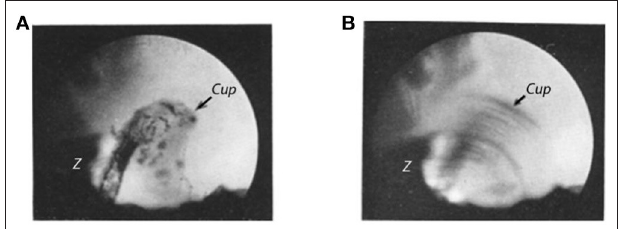
FIGURE 4 | (A) Cupula of a pike. Isolated ampulla of the horizontal semicircular canal. Fixed preparation. The ampullary wall is completely ablated except for vestiges of the zona lunata ( Z ). Pike with a weight of about 2.25kg. Dissected on March 8, 1927, image captured on May 20, 1927. Illumination: